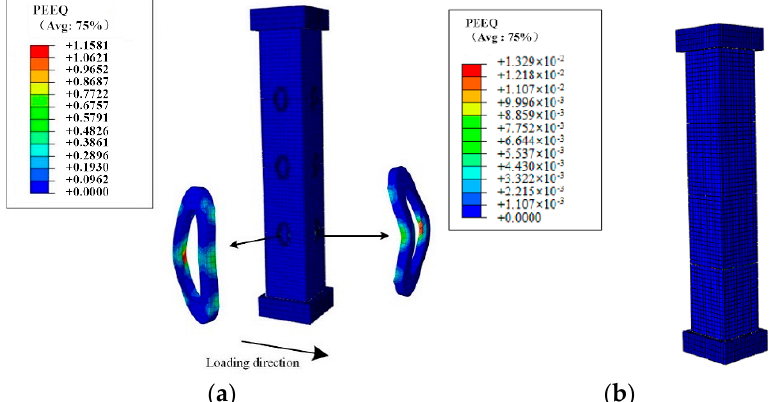
Figure 13. PEEQ (equivalent plastic strain nephogram). ( a ) PSCFST pier with external energy dissipation ring. ( b ) Traditional PSCFSt pier.